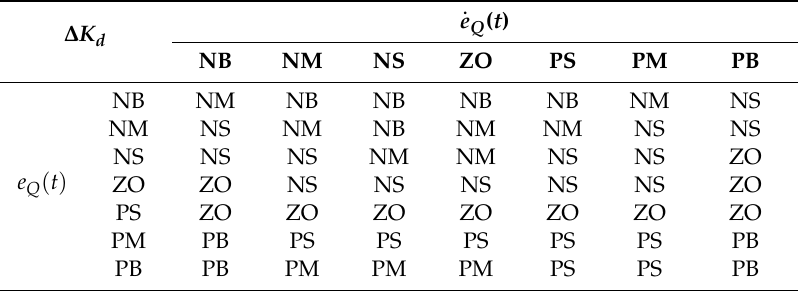
Table 3. Fuzzy control rules for ∆ K d